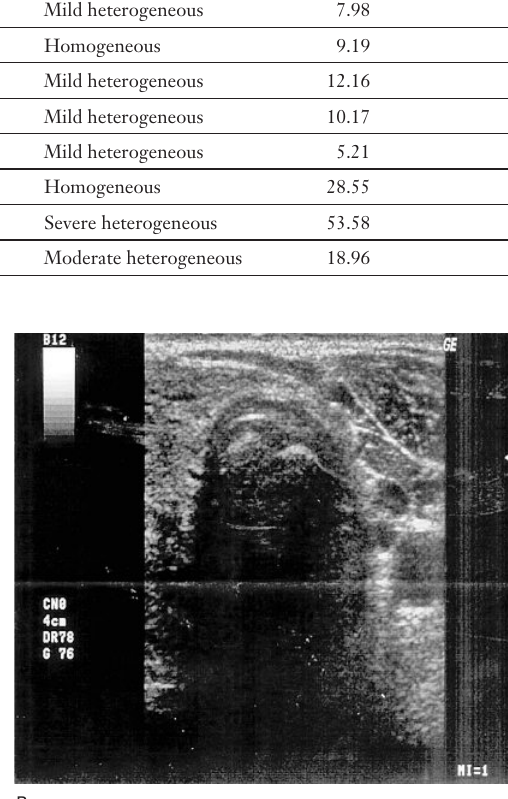
Ultrasonographic features of patients with thyroid hemiagenesis.